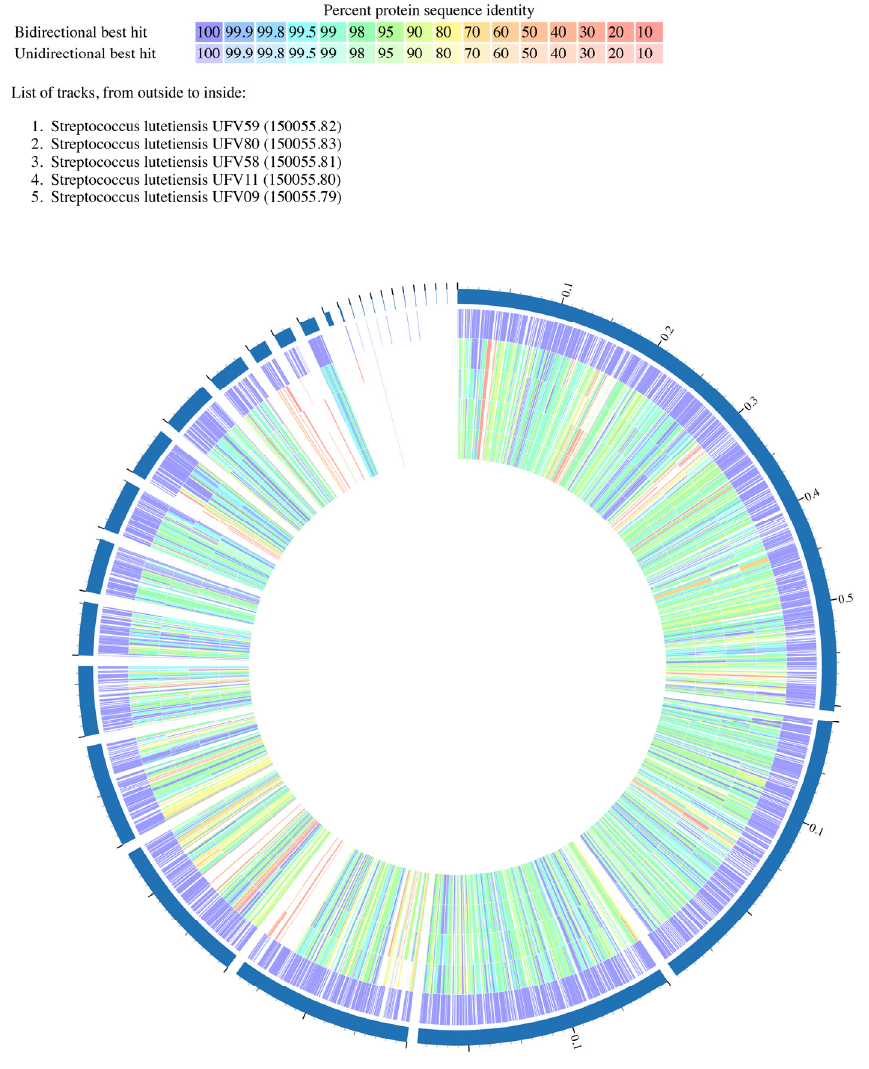
Figure 3. Circular representation of protein conservation in the ruminal Streptococcus lutetiensis genomes. The protein comparisons were performed using the bidirectional BLASTp in the PATRIC platform. S. lutetiensis UFV59 was used as the reference genome.